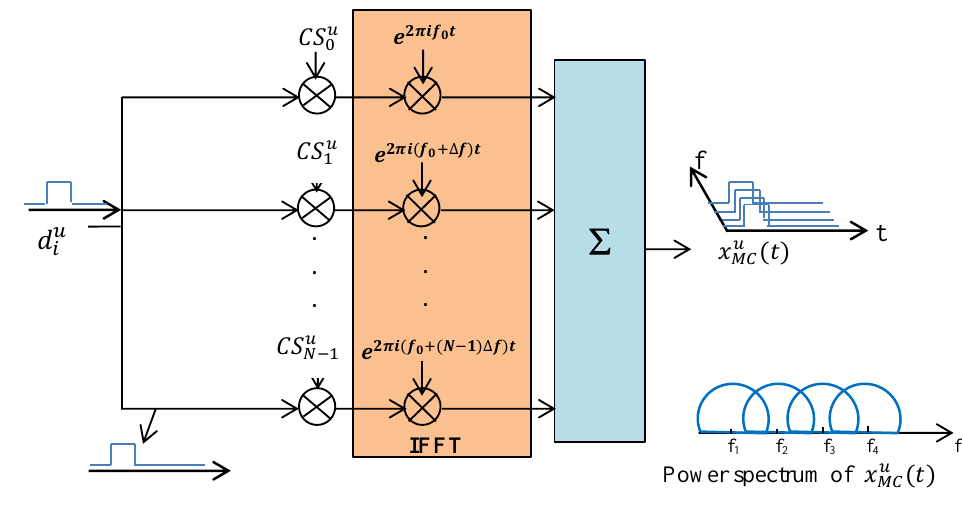
Figure 1. Conventional MC-CDMA